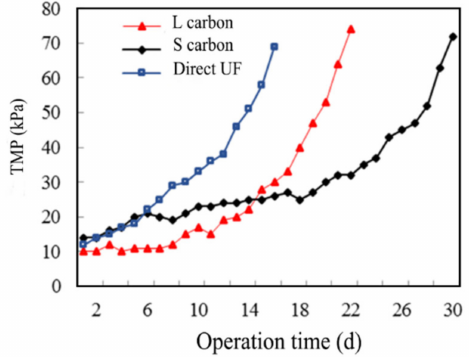
Figure 1. Effects of operating conditions on TMP